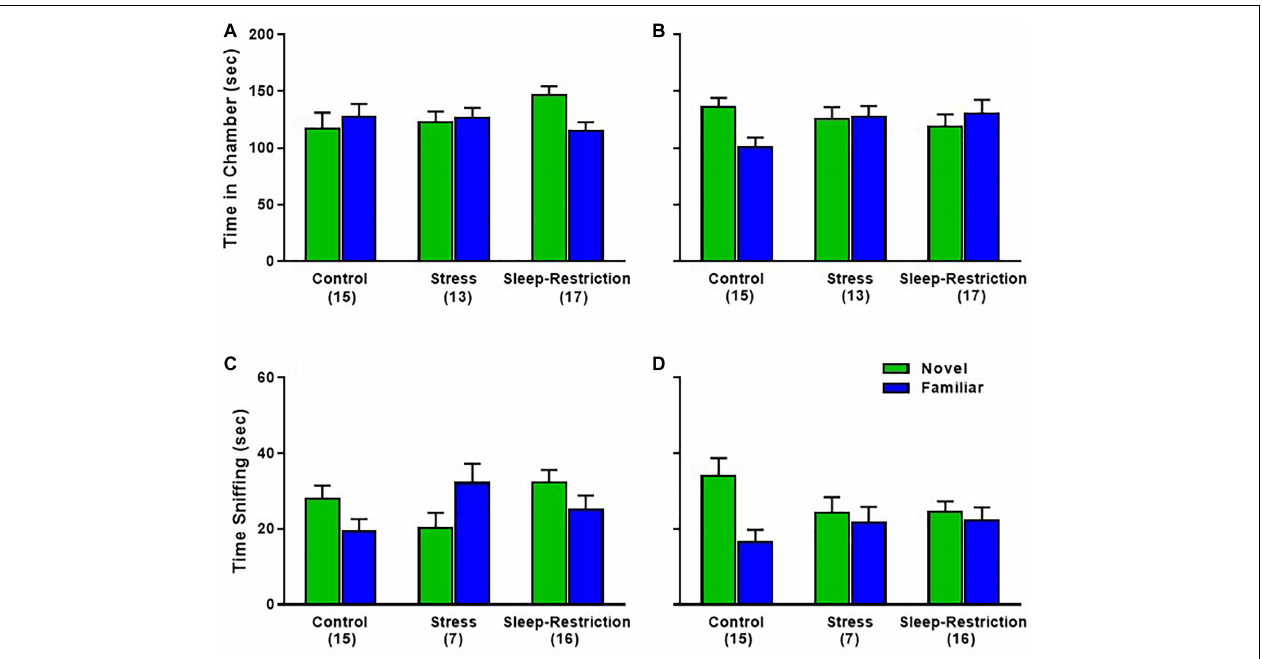
FIGURE 8 | Effects of sleep-restriction on preference for social novelty measured at P48 (A,C) and at P90 (B,D) after recovery. Results of ANOVA are given in Table 2 . (A,B) Time in Chamber: there was a nearly significant age × condition × chamber interaction ( p = 0.056). We proceeded to probe for pairwise differences and found that sleep-restricted mice at P48 and control mice at P90 had a trend toward showing a preference for time spent in the chamber with the novel mouse compared to the familiar mouse ( p = 0.091, p = 0.079, respectively). (C,D) Sniffing time: there was a near significant condition × chamber interaction ( p = 0.061) suggesting that, regardless of age, control mice showed a significant preference for the novel mouse compared with the familiar mouse. Mice in the stress and sleep-restriction groups did not show this preference for social novelty. Each bar is the mean ± SEM for the number of mice indicated in